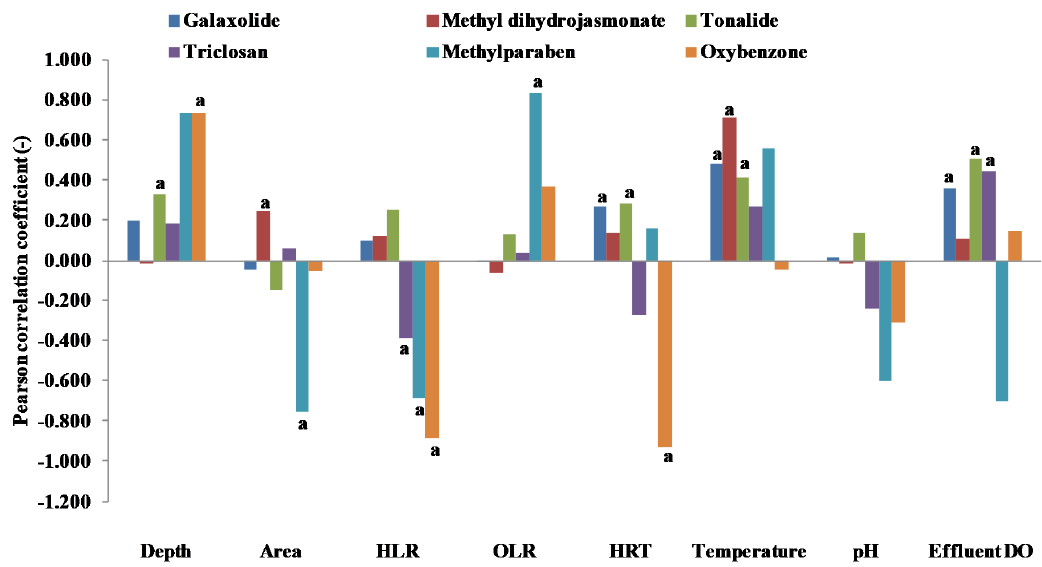
Figure 2. Pearson correlation statistics among the studied factors and the removal e ffi ciency of six selected PCPs. Note: “a” shows a significant correlation between the parameters at 95% confidence level. The number of studies reporting these parameters are di ff erent and hence the number of data points. Galaxolide: the number of data points in the case of depth, area, HLR, OLR, HRT, temperature, pH, and e ffl uent DO were 73, 73, 73, 72, 70, 45, 39, and 48, respectively; Methyl dihydrojasmonate: the number of data points in the case of depth, area, HLR, OLR, HRT, temperature, pH, and e ffl uent DO were 75, 76, 76, 75, 73, 49, 37, and 52, respectively; Tonalide: the number of data points in the case of depth, area, HLR, OLR, HRT, temperature, pH, and e ffl uent DO were 53, 55, 57, 54, 52, 53, 47, and 54, respectively; Triclosan: the number of data points in the case of depth, area, HLR, OLR, HRT, temperature, pH, and e ffl uent DO were 31, 32, 39, 33, 35, 20, 21, and 24, respectively; Methylparaben: the number of data points in the case of depth, area, HLR, OLR, HRT, temperature, pH, and e ffl uent DO were 6, 7, 10, 7, 8, 7, 4, and 7, respectively; Oxybenzone: the number of data points in the case of depth, area, HLR, OLR, HRT, temperature, pH, and e ffl uent DO were 10, 11, 14, 10, 10, 13, 9, and 12,